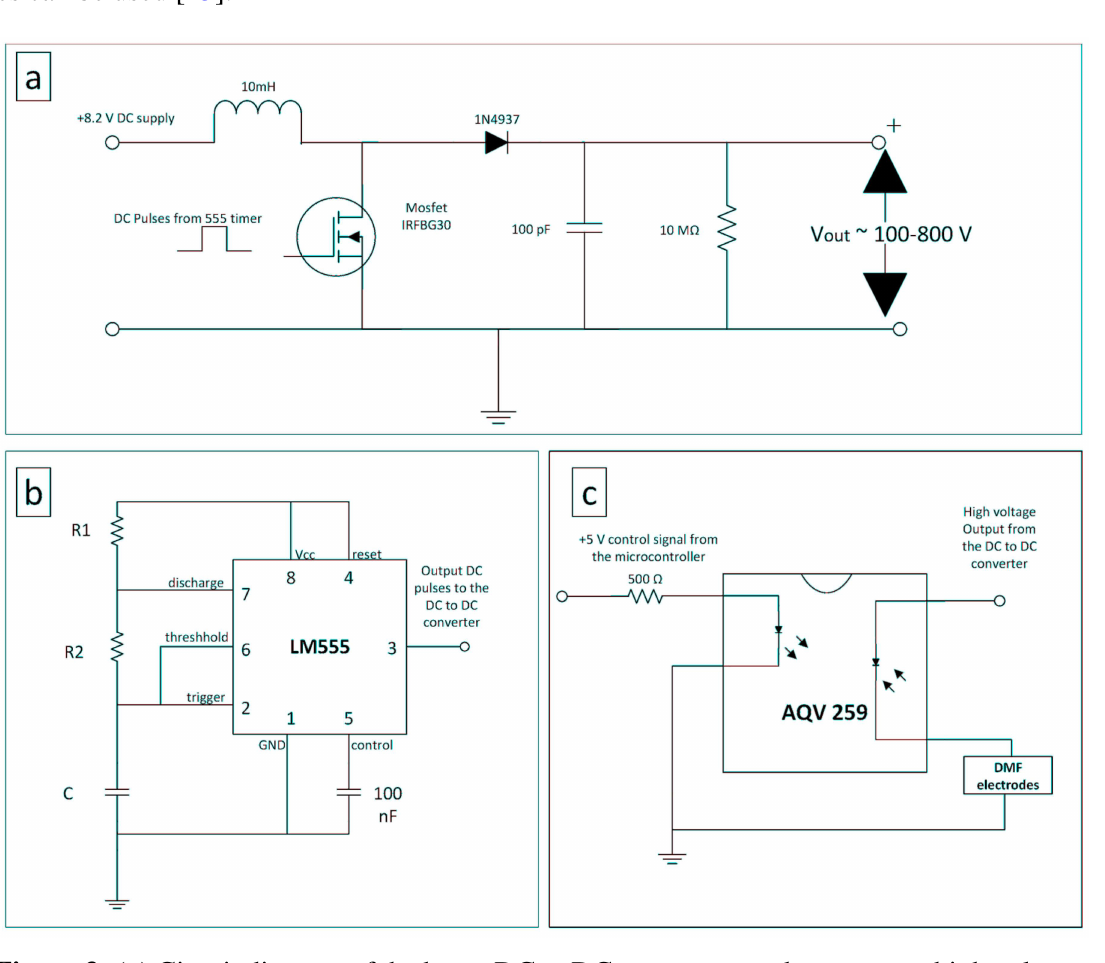
Figure 3. ( a ) Circuit diagram of the boost DC to DC converter used to generate high voltages from the battery source; ( b ) 555 timer circuit used to generate the pulses required for the switched mode power supply; ( c ) The high voltage switching circuit used to control the droplet